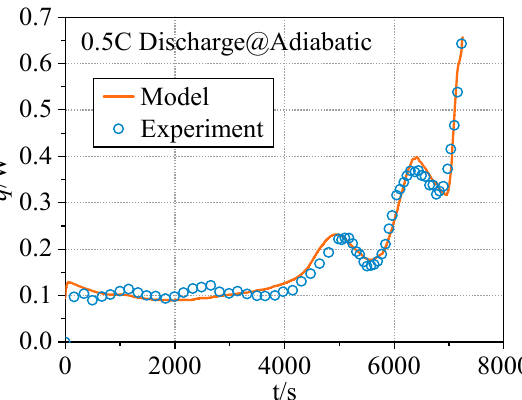
Figure 5. Validation of new battery discharge heat generation power under adiabatic conditions. Figure 6 depicts the calculated findings of battery capacity decline under various operating conditions and the testing results. At the end of the age, when the battery was cycled at 23 ◦ C C1D1 and 23 ◦ C C1D2 working conditions, there was a dramatic decline in capacity. Lithium precipitation from the negative electrode and an increase in the rate of electrode active material loss could both be the real causes of the abrupt decline in capacity [31].